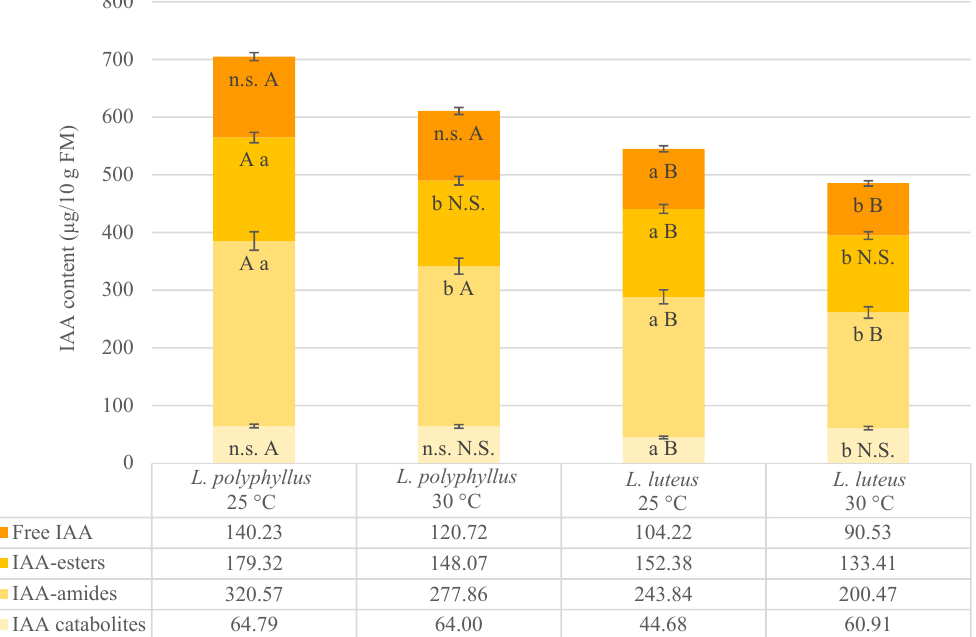
Figure 3. IAA content in hypocotyls of seedlings grown at 25 °C and 30 °C. Vertical bars represent the total IAA content. Sub-bars depict the content of IAA compounds. Values are mean ± SD of three experiments with five replicates in each. Different uppercase letters indicate significant difference ( p < 0.05) between mean values of two lupine species grown under the same temperature; N.S.—non-significant difference. Significant difference between mean values of each lupine species at 25 °C and 30 °C is marked with different lowercase letters; n.s.—non-significant difference.